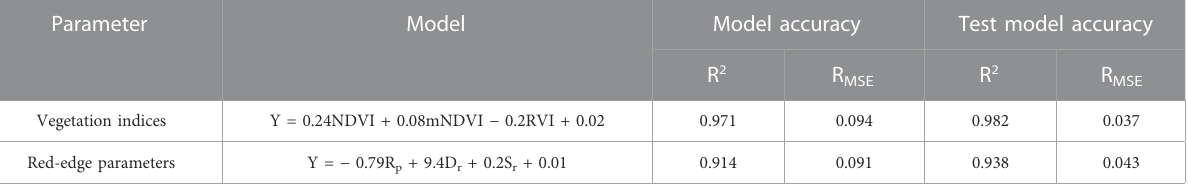
TABLE 4 Partial least squares regression equation.